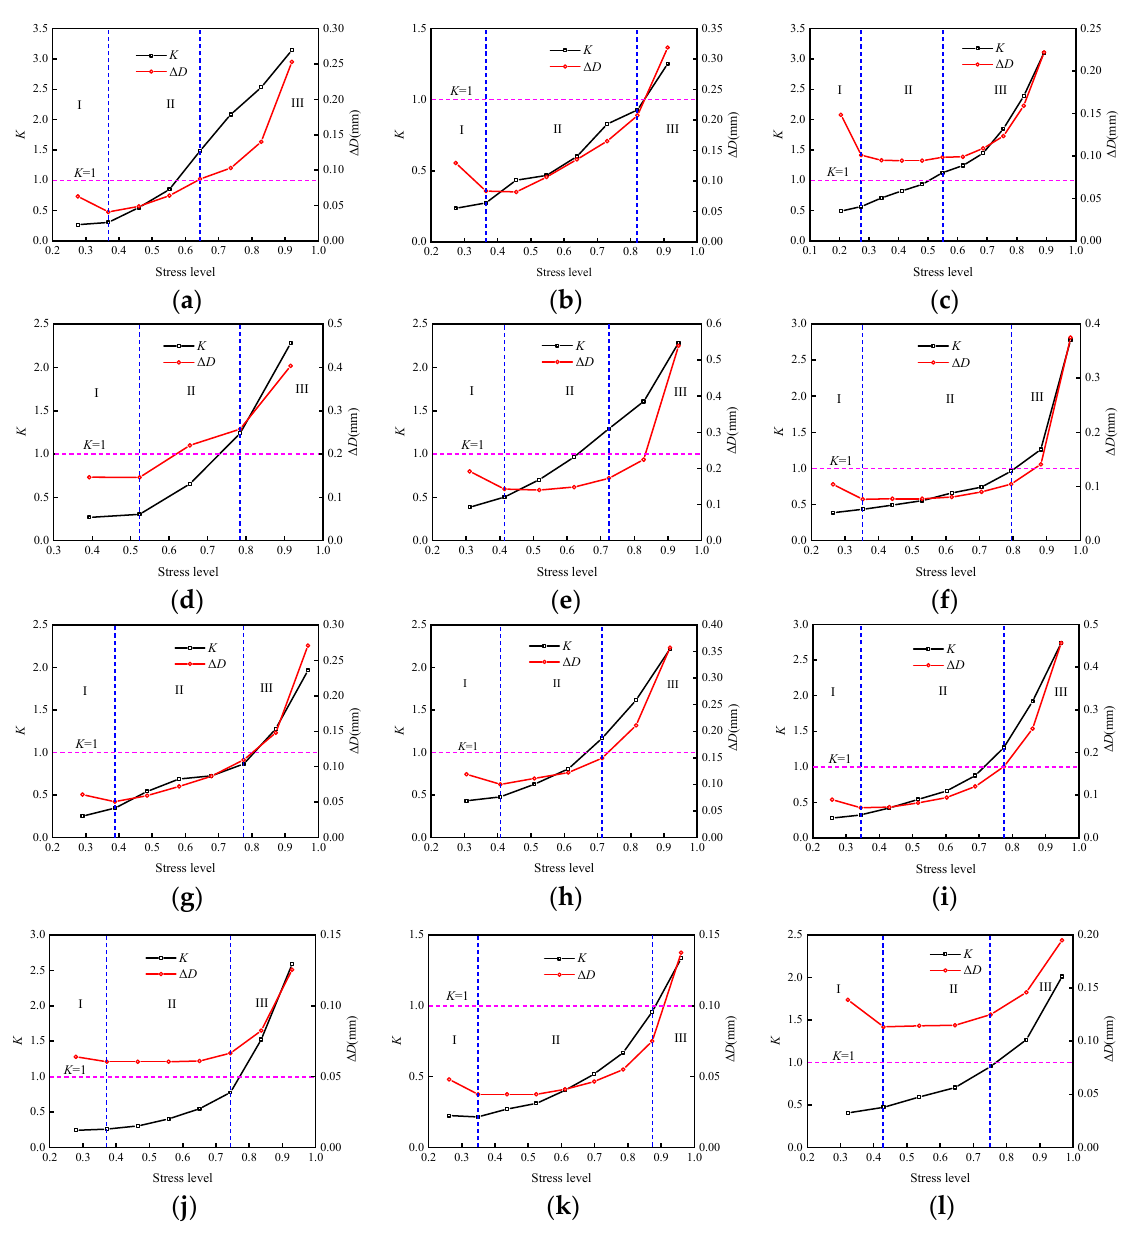
Figure 9. Stress level–energy dissipation ratio deformation of samples under different working conditions ( ∆ D is the total deformation of 10 cycles under different stress levels): ( a ) 1–2.17; ( b ) 1–4.35; ( c ) 1–6.52; ( d ) 4–2.17; ( e ) 4–4.35; ( f ) 4–6.52; ( g ) 8–2.17; ( h ) 8–4.35; ( i ) 8–6.52; ( j ) 10–2.17; ( k ) 10–4.35; (l) 10–6.52.